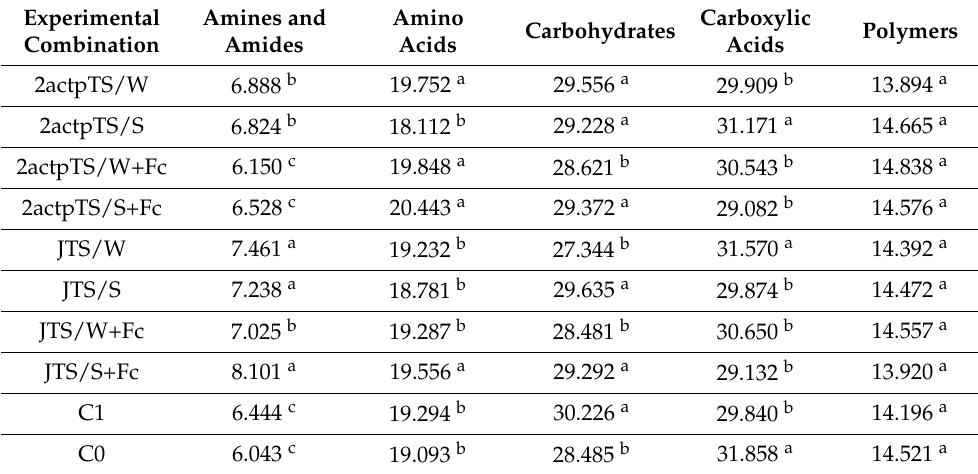
Table 3. Utilization percentage (%) of substrate groups in soil